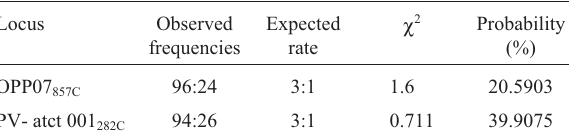
Table 1 - Segregation of the RAPD OPP07 and the SSR PV- atct 001 markers among